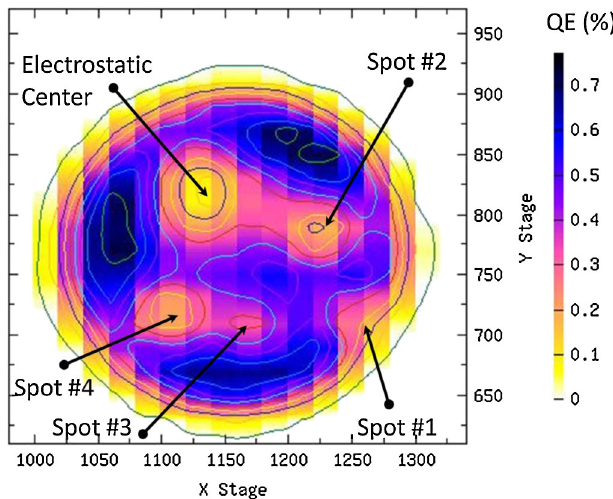
.FIG. 4. (Color) A false-color quantum efficiency (QE) map of the strained-superlattice GaAs photocathode inside the CEBAF inverted gun after production beam delivery from four locations (labeled). The map was obtained by scanning the drive laser beam ( (cid:1) 0 : 5 mm FWHM) across the active area of the photo- cathode (diameter 5 mm), and measuring photocurrent at low bias voltage. X and Y units are arbitrary stepper motor